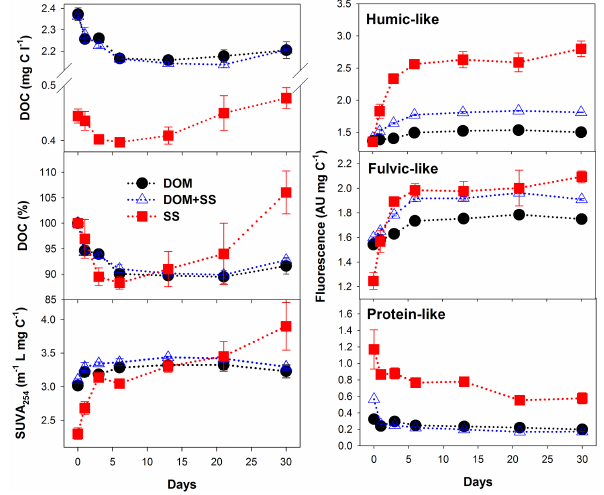
Figure 5. Temporal changes in DOC concentrations (mgCL − 1 or % of the initial concentration), SUVA 254 (LmgC − 1 m − 1 ) , and spe- cific fluorescence (AUmg − 1 DOC) of three PARAFAC components (C1: humic-like fluorescence; C2: fulvic-like fluorescence; C3: protein-like fluorescence) during the 30-day incubation of DOM (filtered stream water), DOM + SS (filtered stream water added with suspended sediment), and SS (ultrapure water added with sus- pended sediment) samples. Error bars indicate ± one standard error ( n =